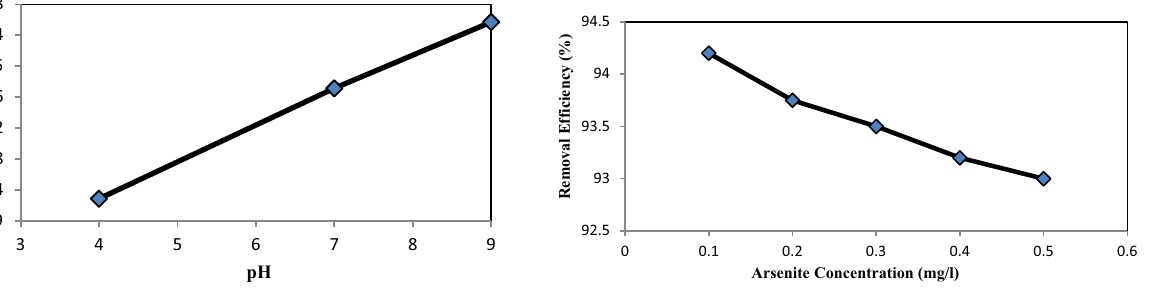
Fig. 2 Effect of pH on arsenic removal at initial concentration of 0.3 mg/L at 120 rpm and temperature 30 °C